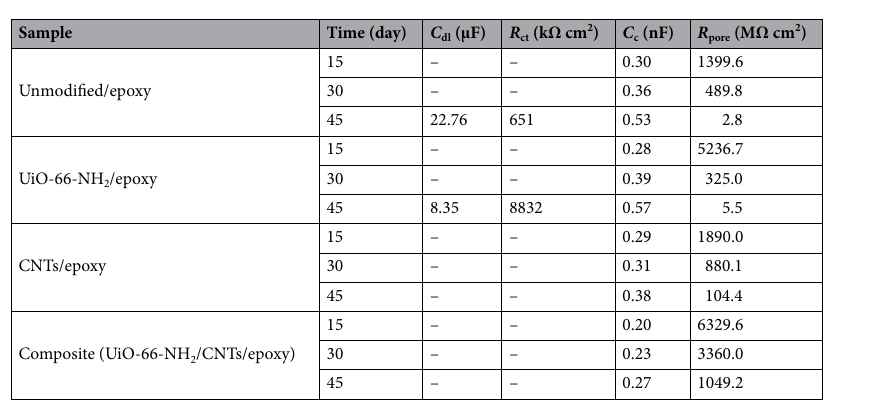
Table 1. Fitting results of the prepared samples after different days extracted from EIS plots. (All tests have been repeated three times).